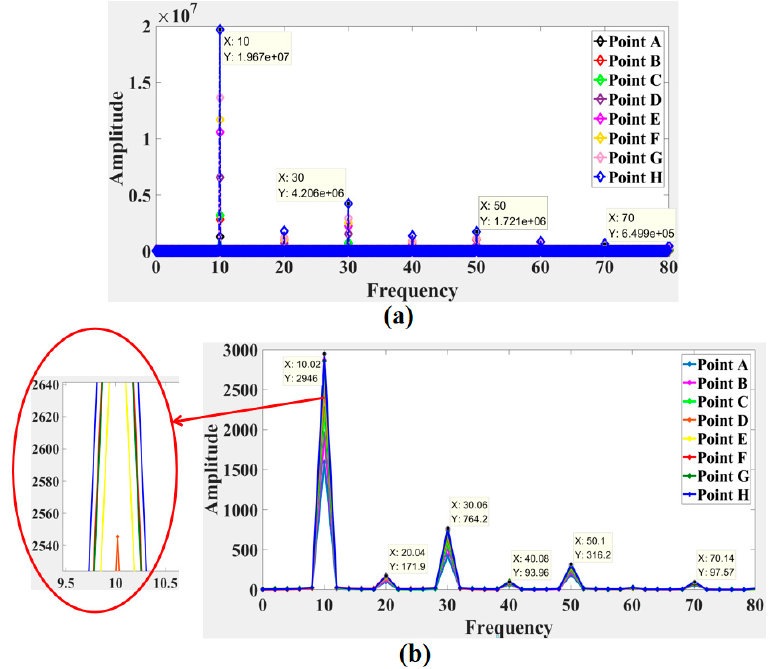
Figure 20. Comparison of the frequency spectrum obtained by ( a ) the LDV signals and ( b ) speckle patterns in the first experiment.